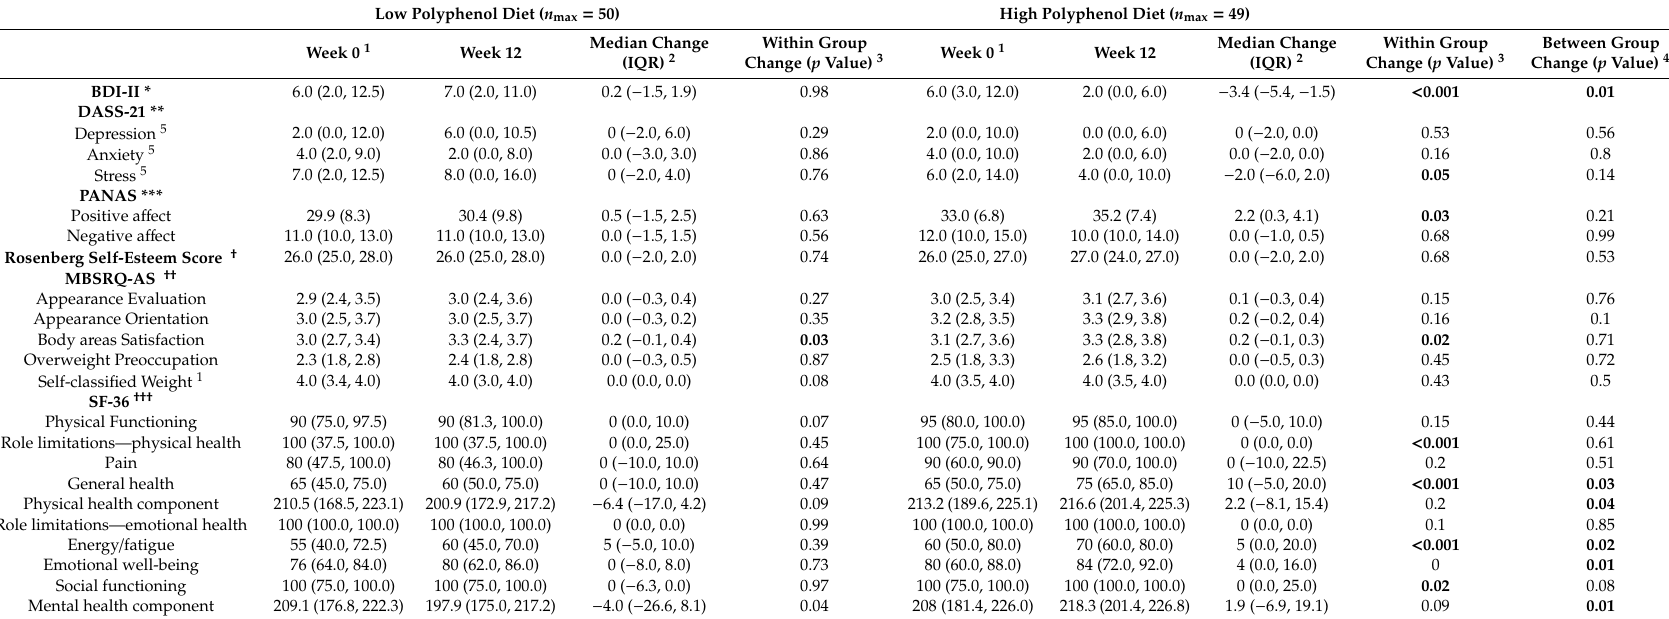
Table 3. Changes in mood, self-esteem, body image and quality of life indicators according to the Polyphenol Intervention Trial (PPhIT) study group